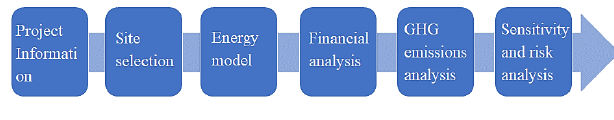
Fig. 8: Flow Chart of RETScreen